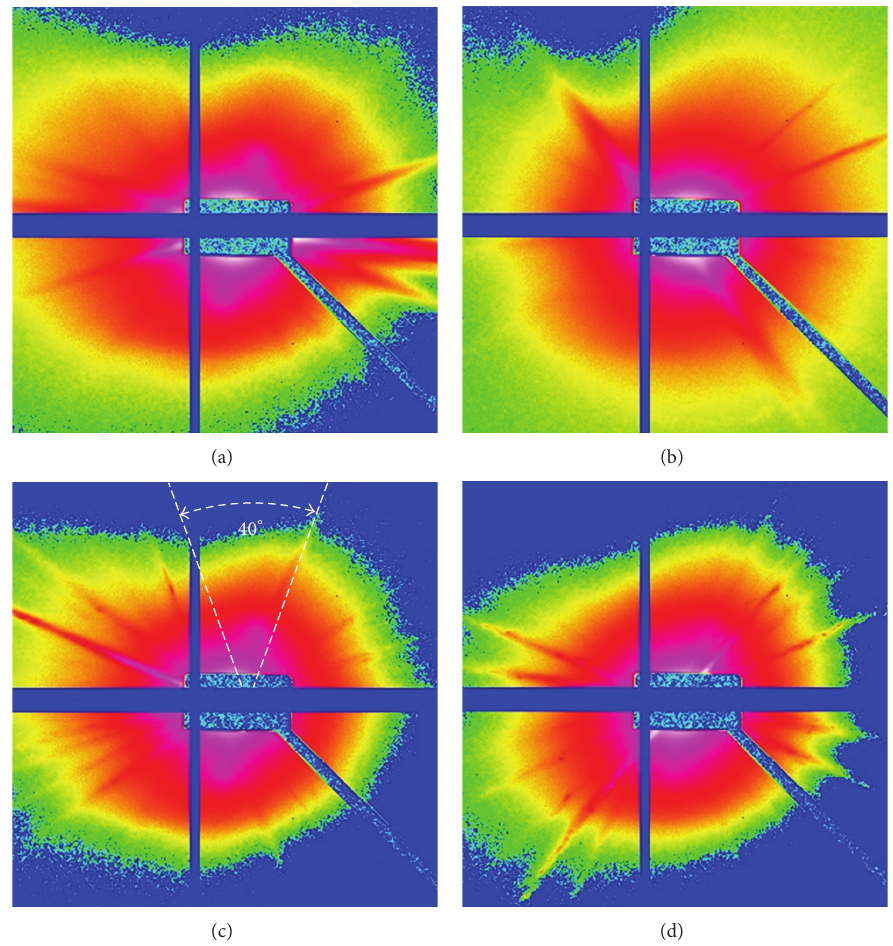
Figure 2: 2D SAXS patterns of the irradiated Al-B metal after being tempered at (a) 400 ∘ C, (b) 500 ∘ C, (c) 600 ∘ C, and (d) 700 ∘ C with logarithmic intensity color